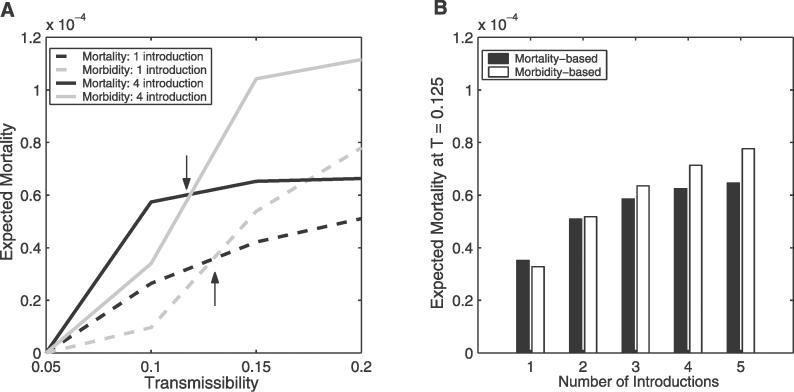
The Epidemiological Impact of Multiple Introductions of Disease(A) The morbidity-based strategy is more effective than the mortality-based strategy when T is less than 0.13 only if there is only a single introduction of disease. With four introductions of disease, however, the morbidity-based strategy becomes less effective (and is the preferred strategy only when T is less than 0.12.)(B) At T = 0.125, the morbidity-based strategy is superior to the mortality-based strategy when there is a single introduction, but inferior when there is more than one introduction.